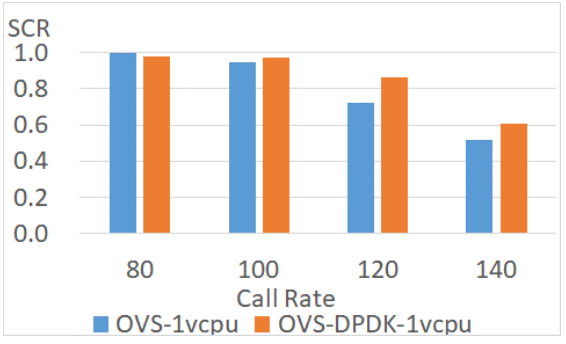
Figure 19. Successful call rate of vIMS with OVS and OVS-DPDK.